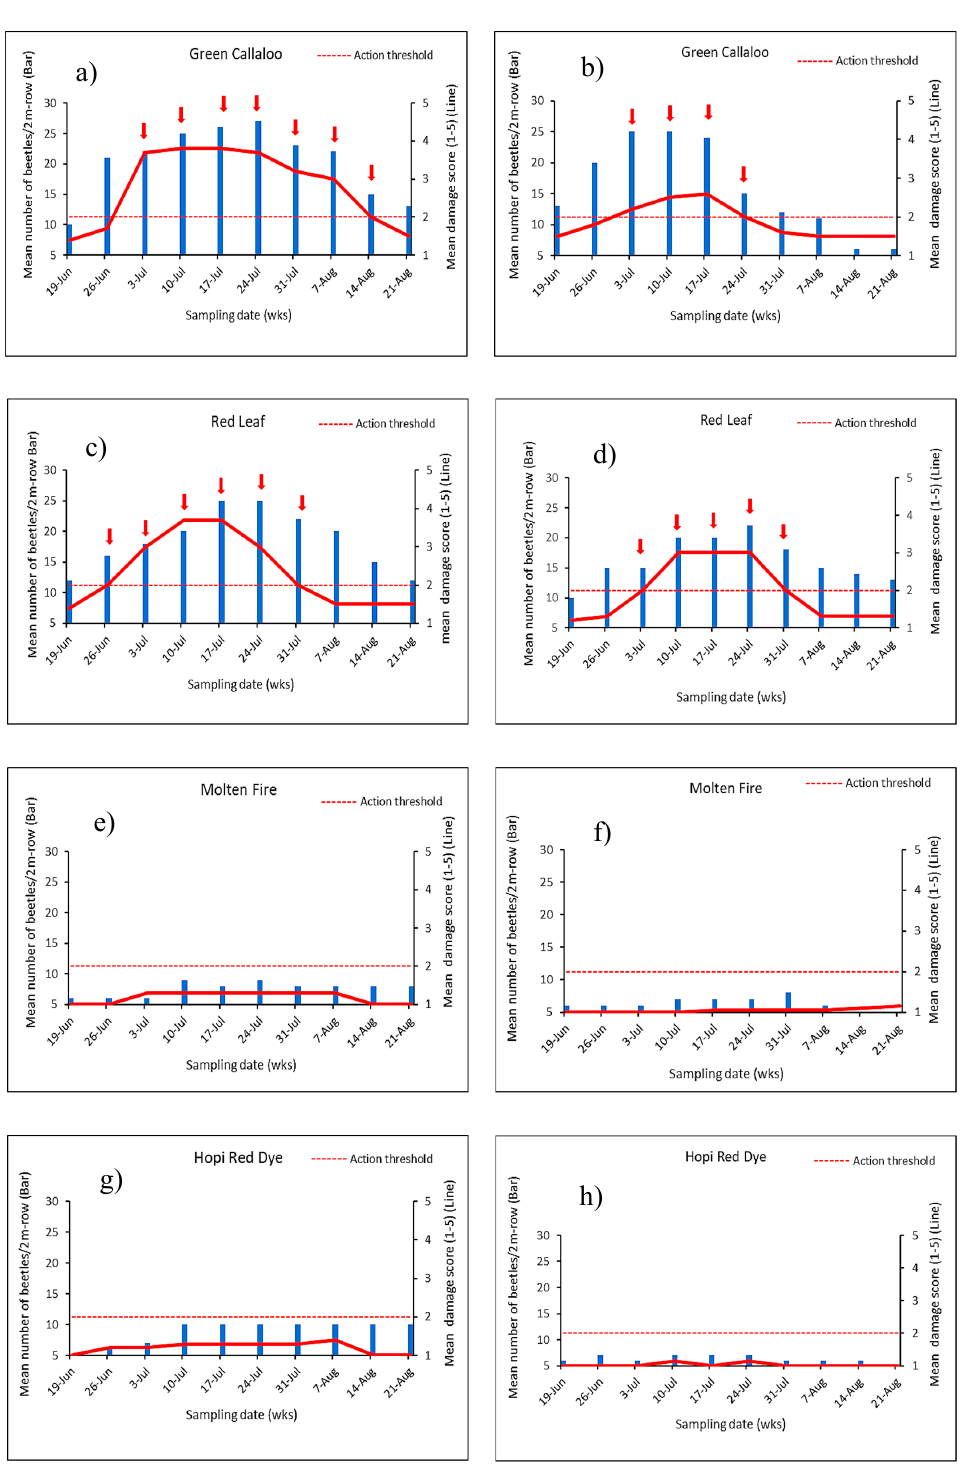
Figure 4. Weekly mean beetle population and the corresponding damage (i.e., scores = 1: 0–20%, 2: > 20–40 %, 3: > 40–60 %, 4: > 60–80 % and 5: > 80–100% leaf damage) and the action threshold for each amaranth variety in 2017. Arrows [in a–d] represent presumptive insecticide treatments ( ≥ action threshold score of 2).